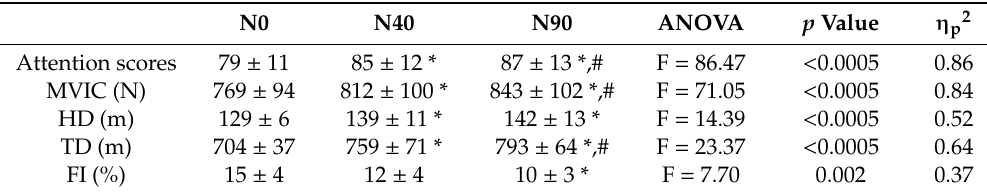
Table 2. Attention, maximal voluntary isometric contraction (MVIC), higher distance (HD), total distance (TD) and fatigue index (FI) recorded during the 5-m shuttle run test in the 40-min (N40) and the 90-min (N90) of nap opportunities and the no-nap condition